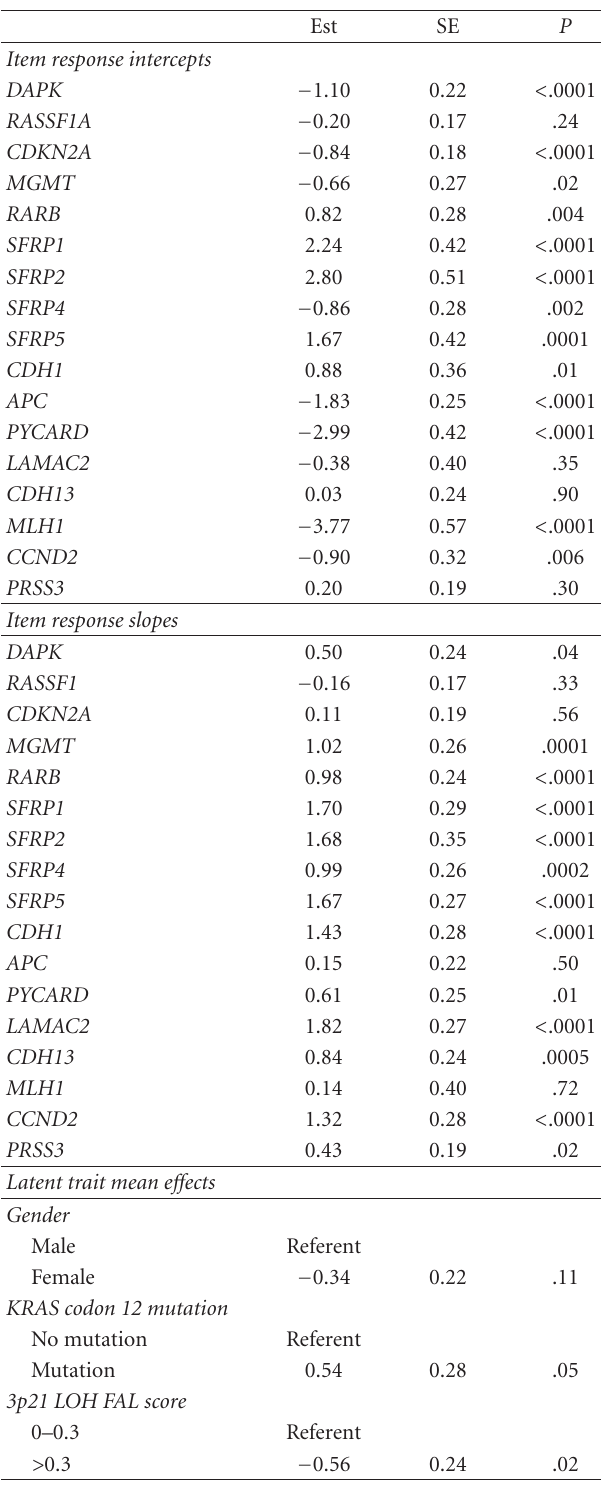
Table 2: Item response model for NSCLC promoter hypermethyla- tion and